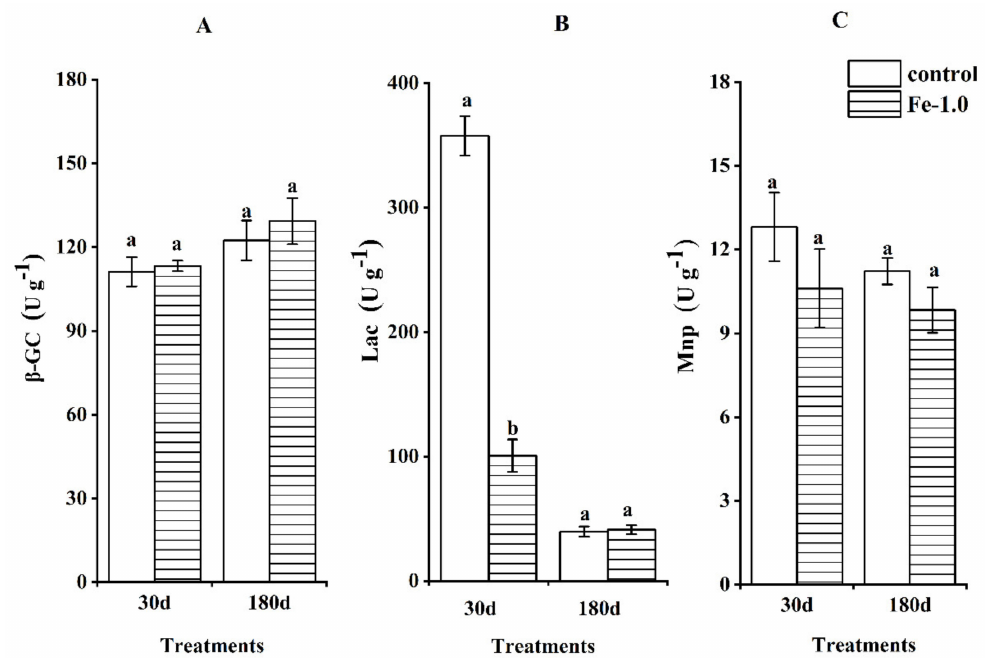
Figure 5. Temporal variations of enzyme activities during incubation. ( A ) β –Glucosidase activity ( β -GC); ( B ) laccase activity (Lac); ( C ) manganese peroxidase (Mnp) activity. Values are means with their standard errors represented by vertical bars. Different letters on the bars indicate the significant differences among the treatments ( p <